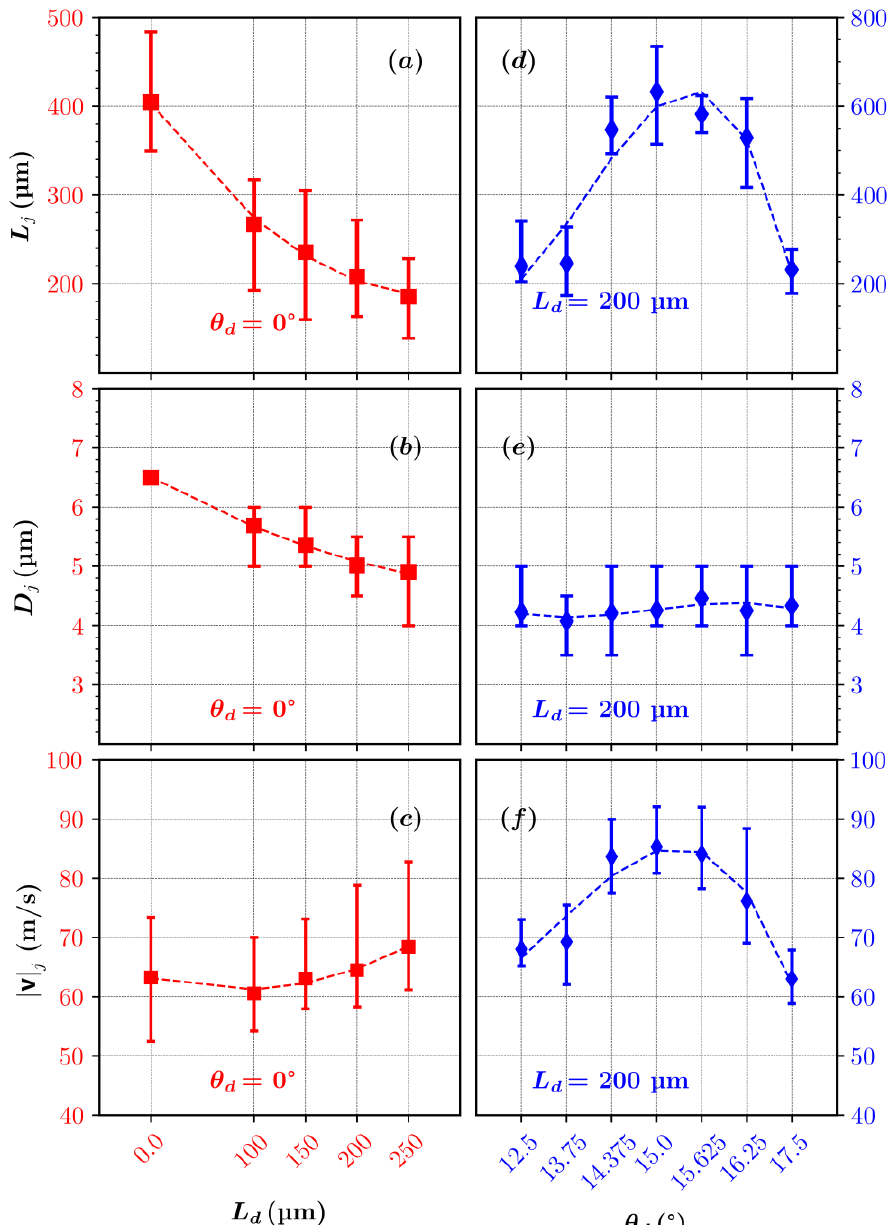
Figure 7. ( a ) Jet length, ( b ) diameter, and ( c ) velocity for 0 ◦ diverging angle and different nozzle outlet channel lengths, and ( d ) jet length, ( e ) diameter, and ( f ) velocity for different diverging angles and 200 µ m of nozzle outlet channel length. The represented averages are calculated over 0.1 ms of simulation time and the error bars represent the minimum and maximum values occurring over averaging interval.